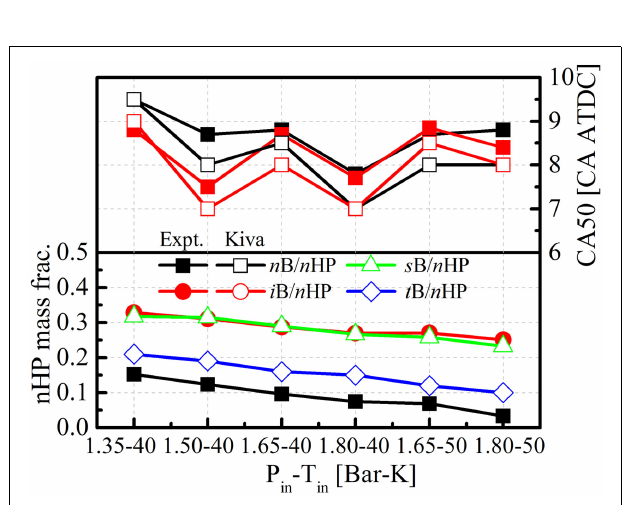
FIGURE 7 | Comparisons of in-cylinder pressure and AHRR between simulations and experiments in the CAT engine .